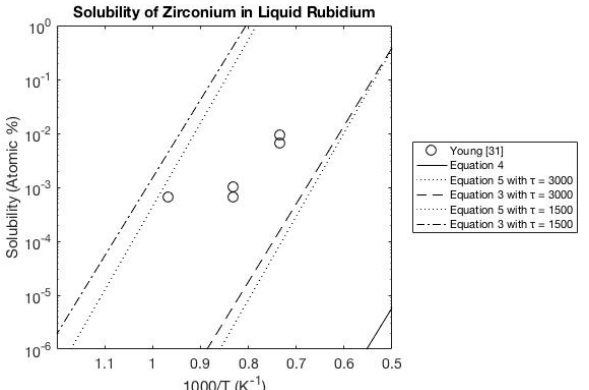
Figure 9. Solubility of zirconium in liquid rubidium.